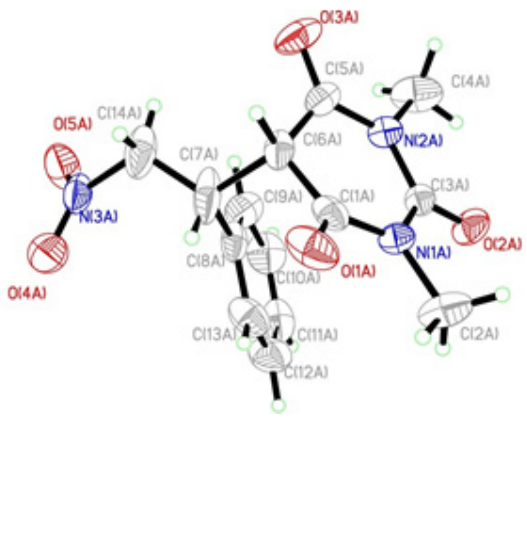
Figure 1. ORTEP representation of the structure of 3a